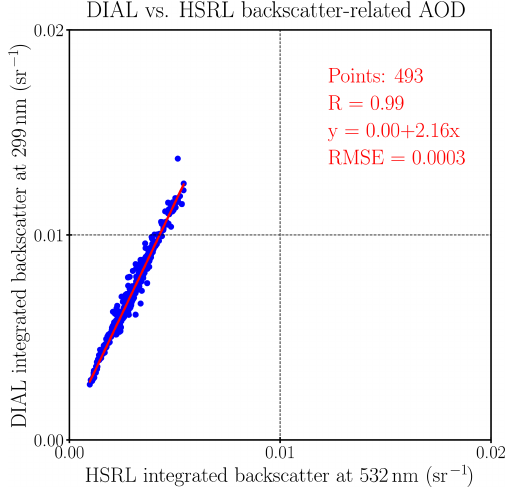
Figure 1. Regression of ozone DIAL- and HSRL-derived integrated aerosol backscatter between 0.4 and 6kma.s.l. using the best least- squares fit, resulting in a backscatter color ratio of 1.34 for 299– 532nm for four cases in 2013. All the data were taken at Huntsville, AL, USA, during summer